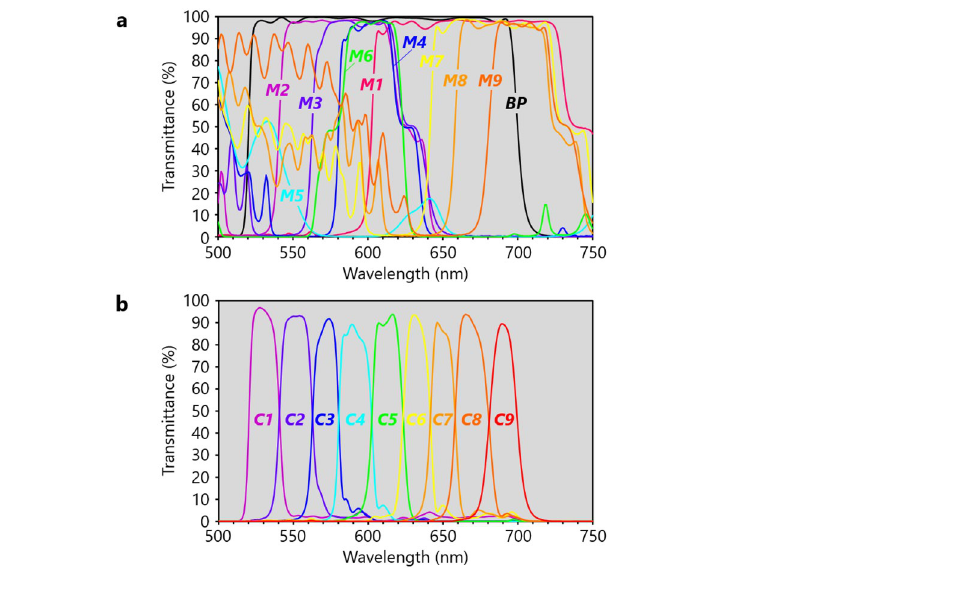
Fig. 3d, in addition to the state shown in Fig. 3c, a smoke-filled acrylic tank is placed in front of the ten-dichroic- mirror array, and the room light is turned off. As a result, nine color split fluxes emitted from the ten-dichroic- mirror array are visible in the tank. Each split flux has a rectangular cross section with size of 1 × 7 mm, which corresponds to the aperture size of the novel nine-color spectrometer. In Fig. 3b, a piece of paper is placed in front of the ten-dichroic-mirror array in Fig. 3c and 1 x 7-mm images of the nine color split fluxes projected on the paper are observed from the traveling direction of the nine color split fluxes. The nine color split fluxes in Fig. 3b and d are C4 , C3 , C2 , C1 , C5 , C6 , C7 , C8 , and C9 in order from top to bottom, as also understood from Figs. 1b and 2c. These are observed in colors corresponding to their respective wavelengths. Since intensity of the LED white light (see Supplementary Fig. S3) and sensitivity of the color camera used for taking photographs in Fig. 3 in regard to C9 (682–699 nm) are both low, the observed intensity of C9 (the flux at the bottom) is weaker than that of other split fluxes. Similarly, C9 was faintly observed with the naked eye. Meanwhile, C2 (the second flux from the top) looks green in Fig. 3, but looks more yellow to the naked eye.